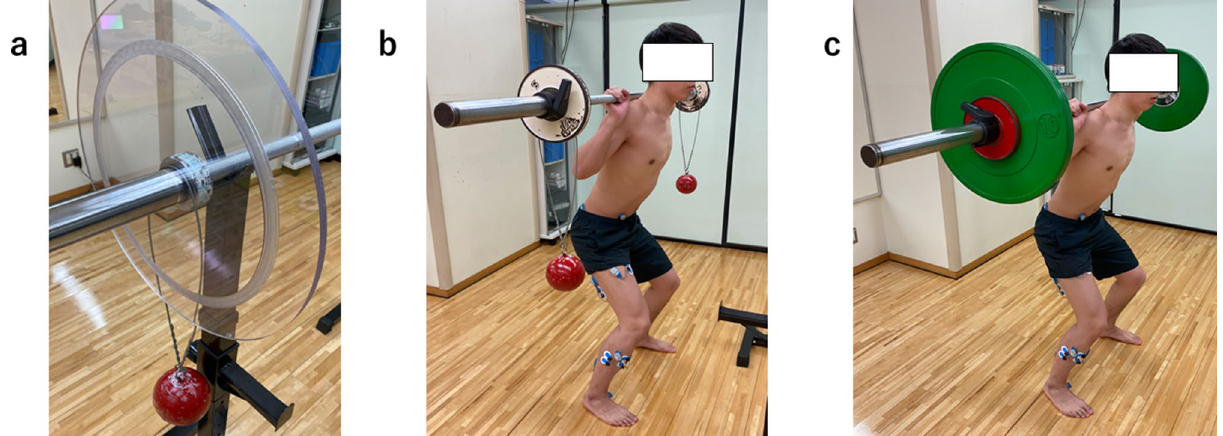
Figure 1. Explanation of Hammerobics-synchronized squat and the conventional isometric squat. ( a ) Hammerobics hammer setup. ( b ) Hammerobics-synchronized squat. ( c ) Conventional isometric